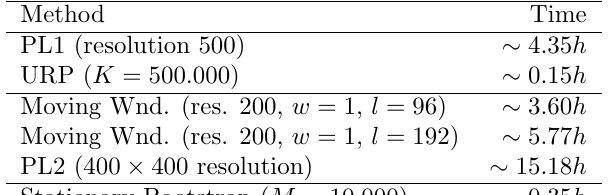
Table 6: Computation time for the LP model from the Step data-set. The other data-sets produce comparable execution